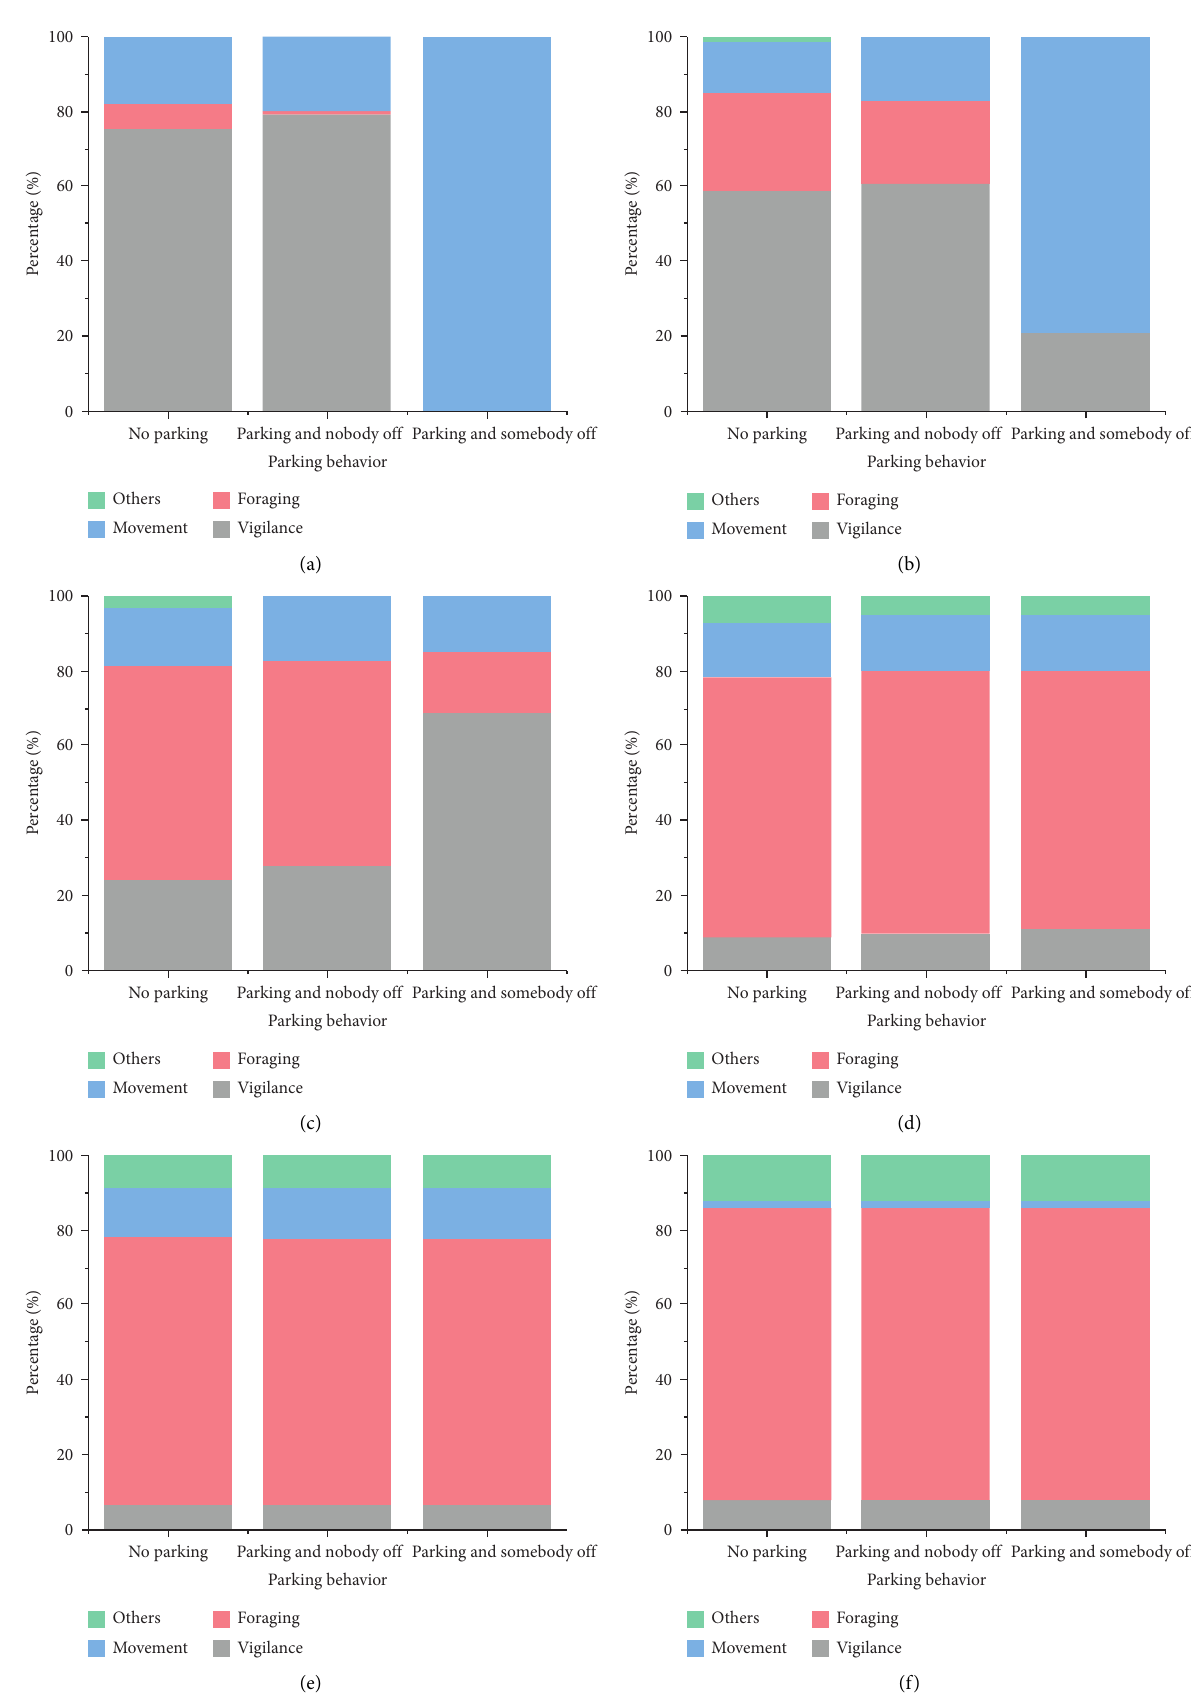
Figure 7: Changes in Tibetan antelope behavior at different distances from the highway. (a) 0–50m. (b) 50–150m. (c) 150–300m. (d) 300–400m. (e) 400–500m. (f) 500m and